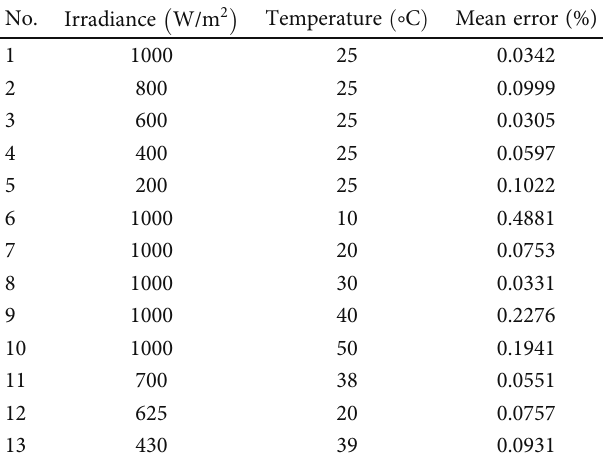
Figure 13: Accuracy of the PVE, measured by the relative error as a function of the output resistance for varying temperatures and constant irradiance ð 1000 W/m 2 Þ . Table 2: Mean error as a function of the PVE resistance (short circuit to open